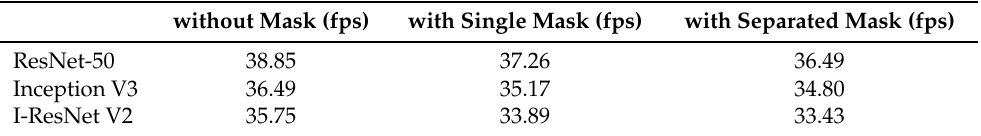
Table 8. The frame rate of PAR network with and without attention masks. without Mask (fps) with Single Mask (fps) with Separated Mask